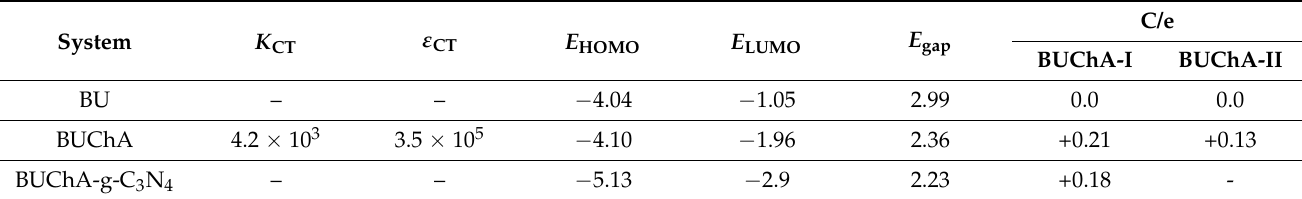
Table 1. Measured formation constant ( K CT , M − 1 ), extinction coefficient ( ε CT , M − 1 ), calculated HOMO energies, LUMO energies, energy gap, and Hirshfeld atomic charges for the BUChA adduct.